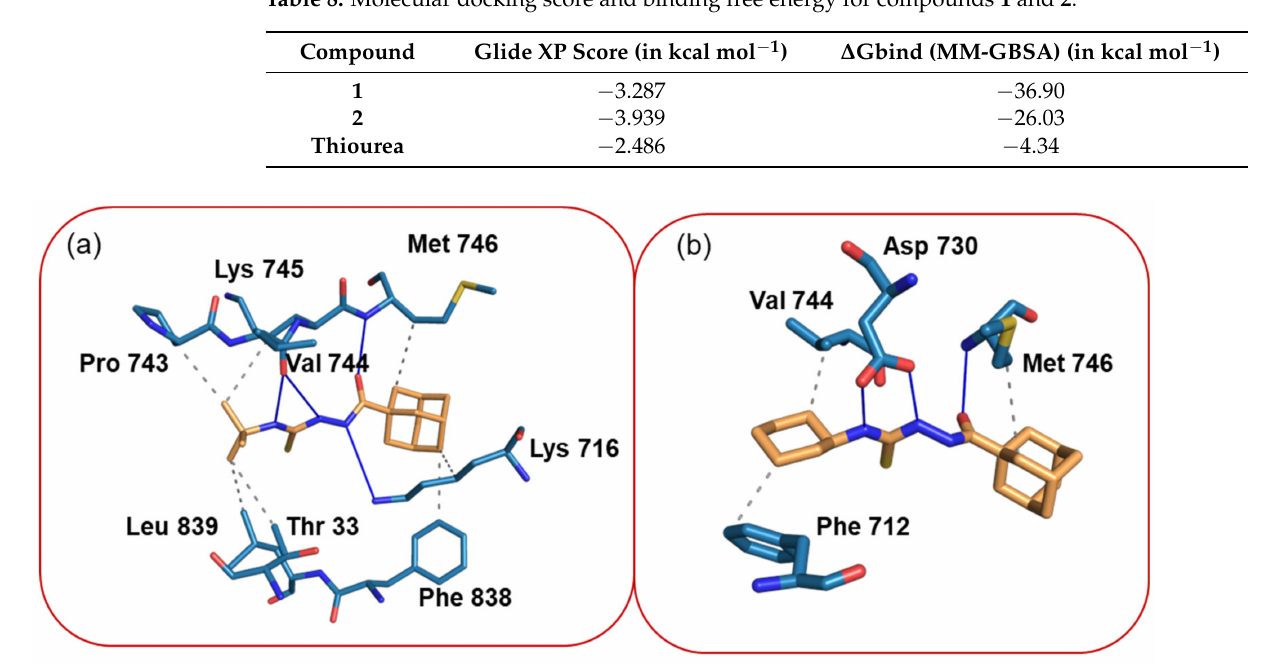
Figure 6. ( a ) Interactions between compound 1 and active residues of the urease enzyme and ( b ) intermolecular interactions between compound 2 and active site residues of the urease